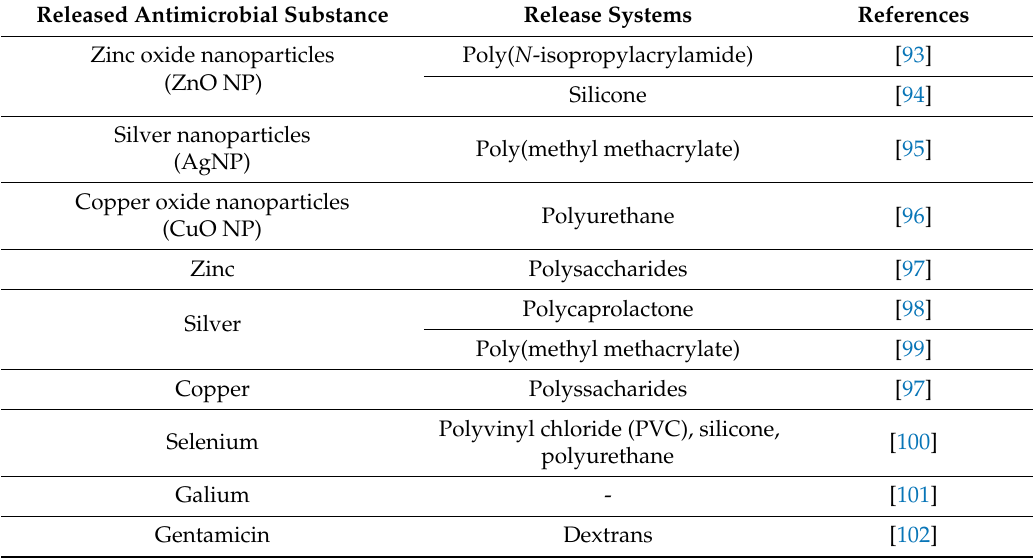
Table 2. Examples of biocide-releasing systems for antimicrobial applications with biomedical